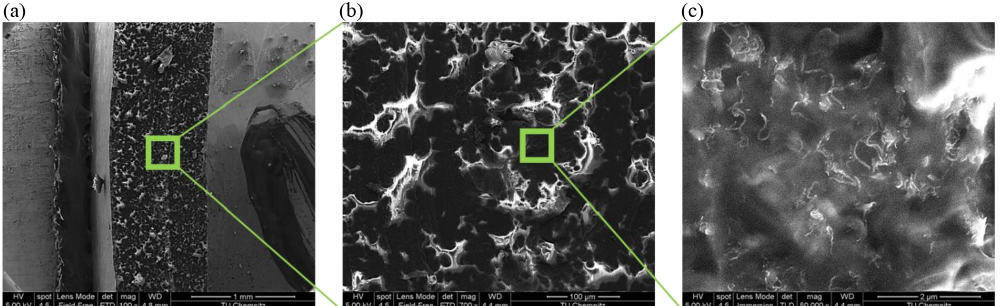
Figure 7. SEM images at different magnification: (a) the cross-sectional view of the sample; (b) macroscopic view showing the region of polymer and CNTs; (c) immersion view showing the homogeneity of CNT distribution in the polymer.